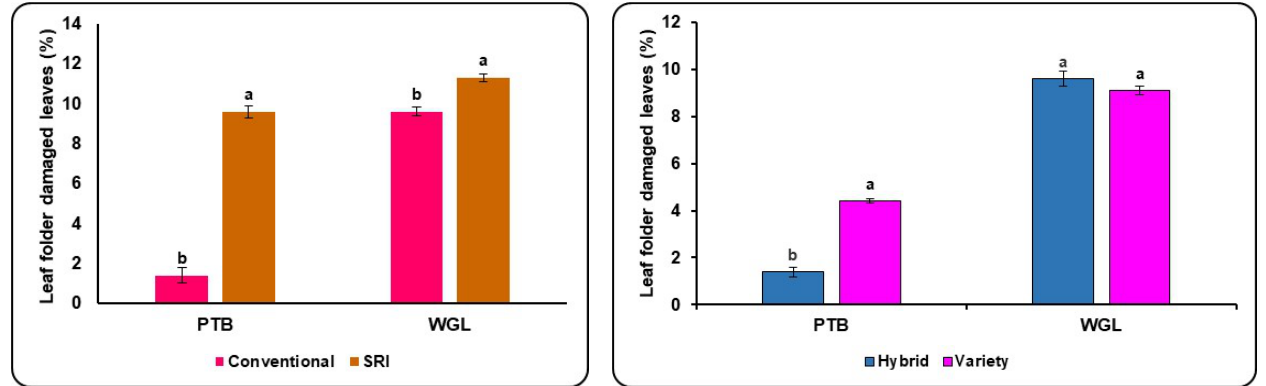
Leaf folder incidence was observed at two locations, Pattambi and Warangal. At both of these locations, leaf folder damage was found to be higher with SRI methods compared to conventional methods. The highest incidence was observed with SRI methods at Warangal (11%), where the incidence was at par for both hybrids and varie ‐ ties (Figure 4).